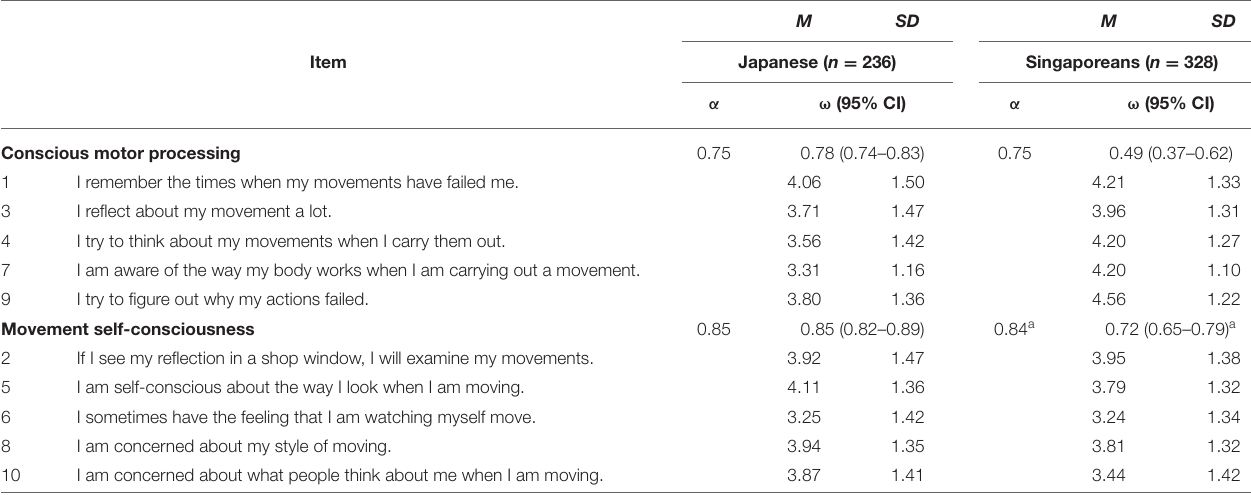
TABLE 1 | Descriptive statistics of item scores for Japanese and Singaporean